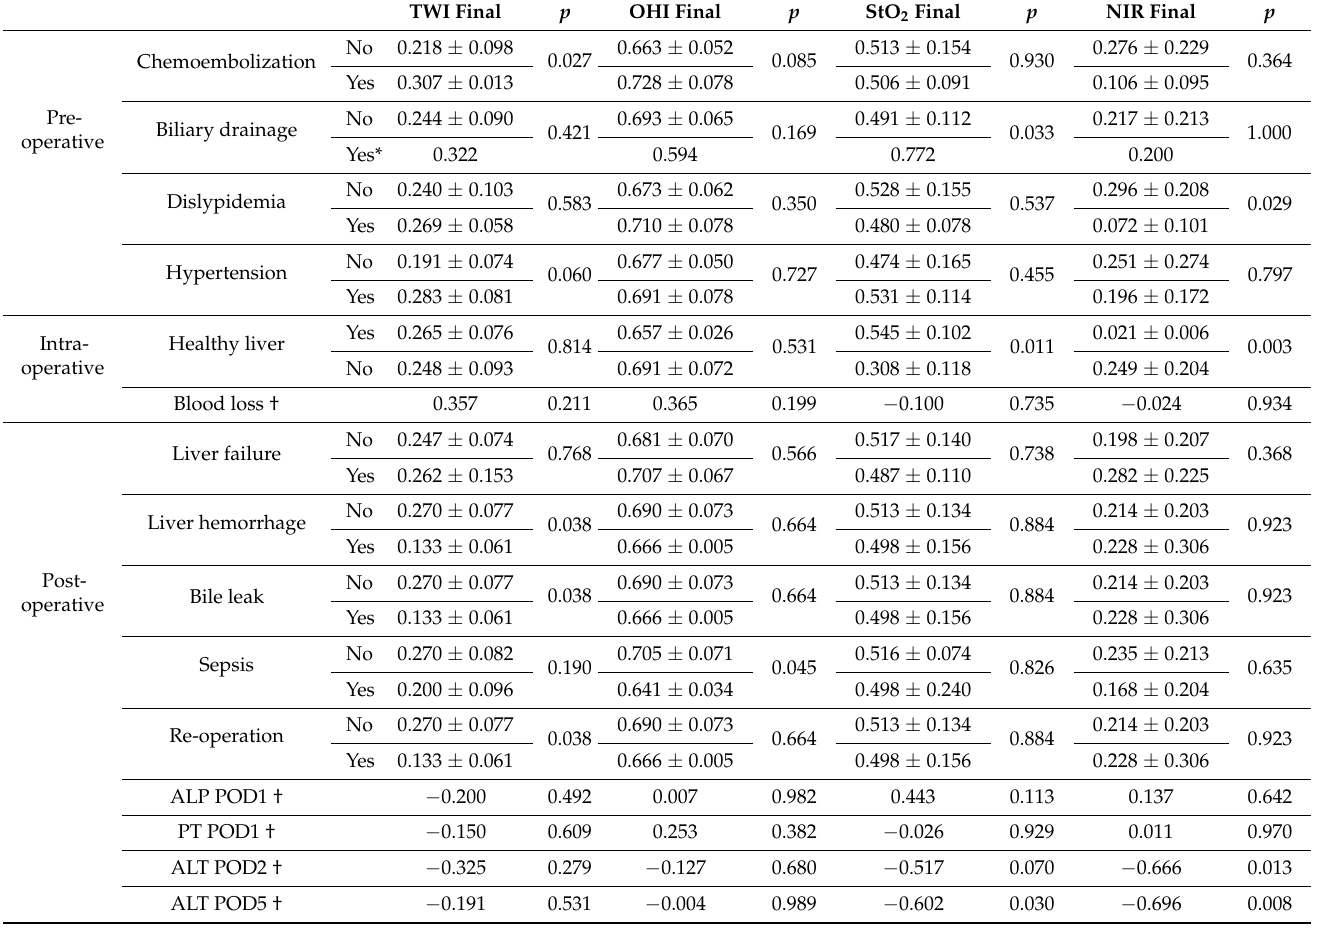
Table 3. Comparisons between final hyperspectral indexes and different peri-operative